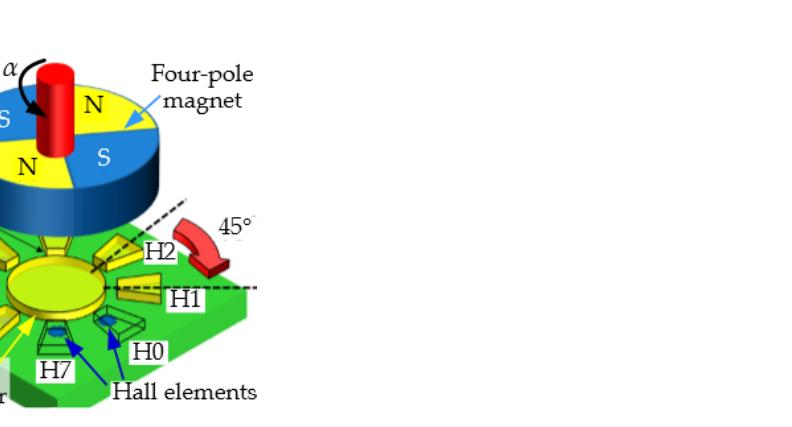
Figure 1. Concept diagram of the magnetic sensor and 4-pole magnet. The sensor consist of an array of 8 Hall elements covered by a magneto-concentrator structure. This arrangement is sensitive to the field gradient in the XY plane. Uniform stray fields are rejected. The figure is extracted from [8] (license CC BY 4.0).